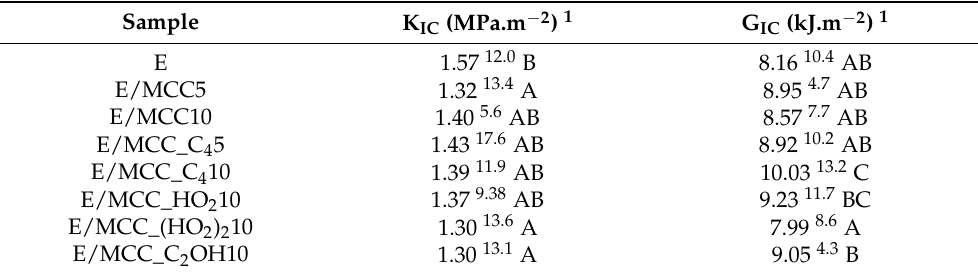
Table 5. Fracture toughness (KIC) and strain energy release rate (GIC) for epoxy and the MCC/epoxy